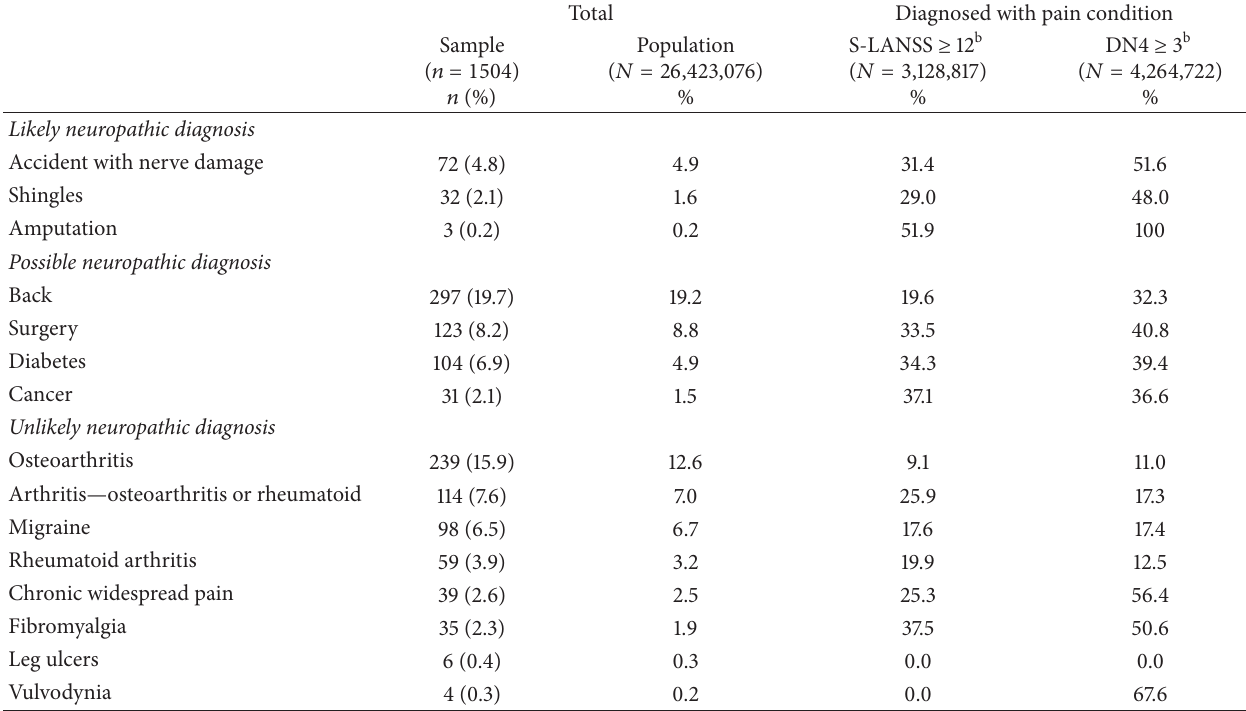
Table 2: Percent of respondents with pain-related diagnoses who were screened positive for neuropathic characteristics on the S-LANSS and the DN4 a